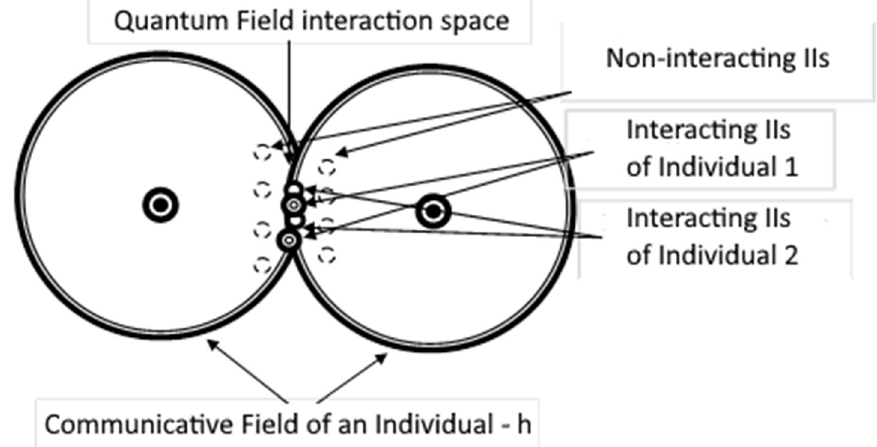
Figure 1. Interaction of communicative fields of two individuals.